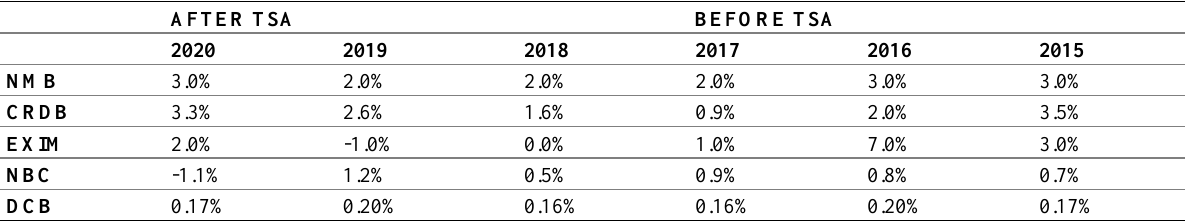
Table 5: Return on Assets